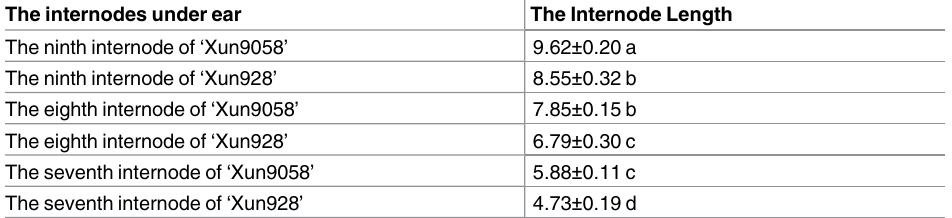
Data of each sample was the means from 60 plants. Different lower case letters in the column indicate significant differences at P (cid:20) 0.05 according to least significance difference tests. Data represent the mean values ±